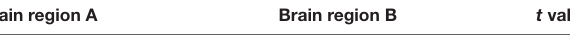
TABLE 3 | Inter-regional changes and functional connectivity in the AUD group compared with the HC group. Brain region A Brain region B t value Right dorsolateral prefrontal cortex Right superior occipital gyrus 3.58